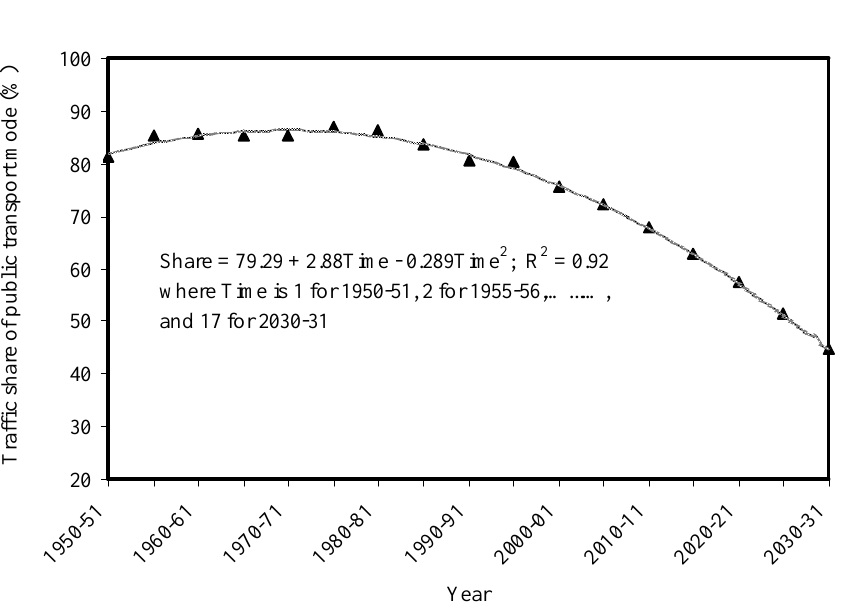
Figure 2. Projection of traffic share of public transport mode (buses) up to the year 2030-31